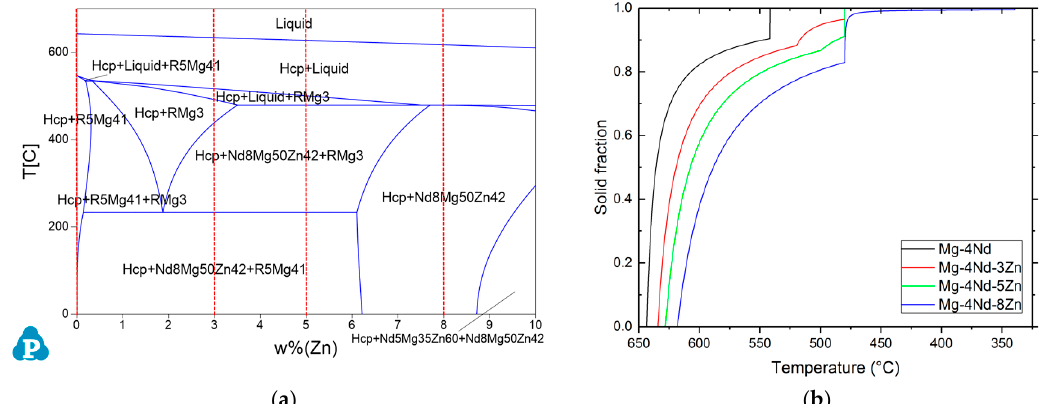
Figure 1. ( a ) Pseudo-binary diagram for the Mg-4Nd- x Zn ( x = 0 to 10 wt %) system calculated using PandaT. Red dashed lines represent the alloy compositions used in this work; Zn = 0, 3, 5 and 8 wt %; ( b ) Scheil solidification calculations.